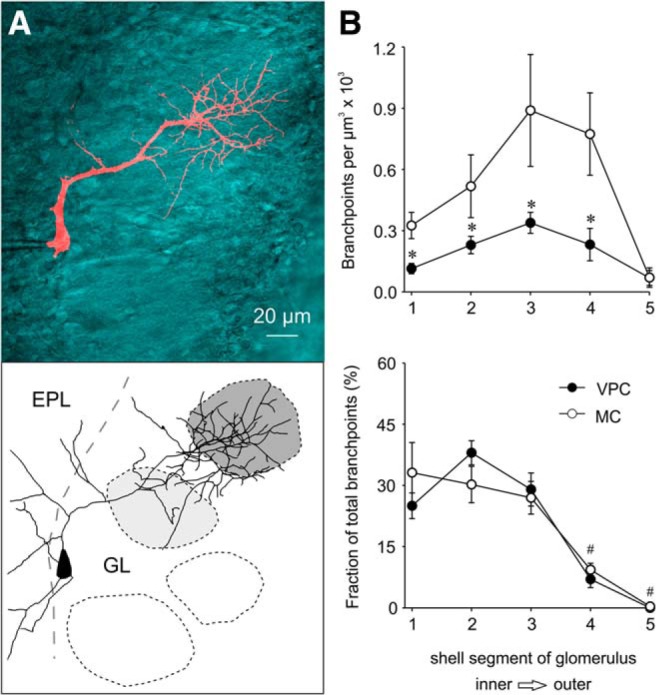
A, Maximal z-projection of a VPC filled with AlexaFluor 594 and overlaid with the single z-plane of the trans-infrared channel that showed the maximal extent of the innervated glomerulus. Bottom, Reconstruction of cell above. The dark gray shading indicates the glomerulus innervated by the dendritic tuft of the respective VPC. The other glomeruli have no contact with the VPC (white) or lie above or underneath the dendrites of the VPC (light gray shading). Imaging was performed in acute slices (300 µm) using two-photon laser scanning microscopy. B, Density of branch points and fraction of total branch points within shell segments of the respective glomerulus in VPCs (n = 13) and MCs (n = 8). Statistical comparisons indicate a lower branch point density but similar branch point distribution in VPCs compared with MCs. * p < 0.05 versus respective MC; # p < 0.05 versus segment 1 + 2; mixed-model ANOVA followed by post hoc test with Bonferroni correction. MC, mitral cell; VPC, vasopressin cell.